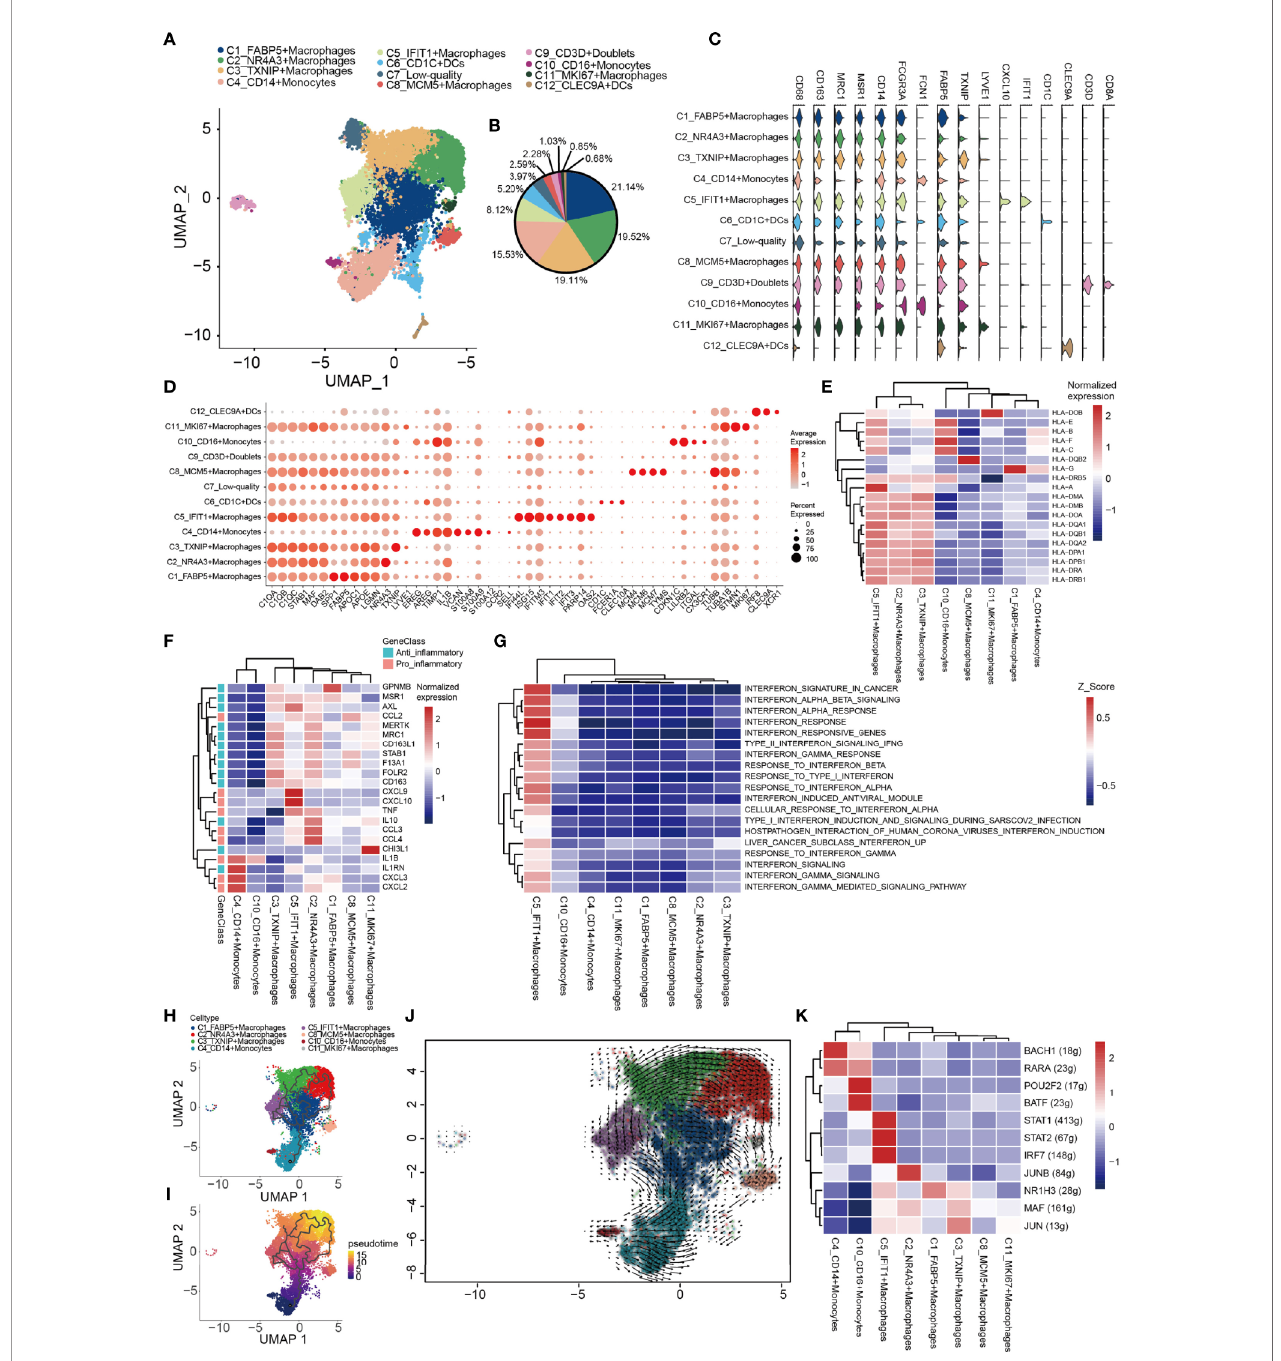
FIGURE 5 | Heterogeneity of myeloid cells populations in human OS. (A) UMAP plot showing the myeloid cells, with different cell types represented by the different colors. (B) Pie chart showing the cell composition of myeloid cells, with different cell types represented by the different colors. (C) Violin plots showing relevant marker genes of the myeloid cell subtypes. (D) Dot-plot of marker genes in each cell subtype; shades of red represent the expression level, and dot sizes represent the relative abundance. (E) Heat map showing the encoding major histocompatibility complex class I and II molecules of the genes of each macrophage subtype. (F) Heat map showing the anti-in fl ammatory and pro-in fl ammatory genes of each macrophage subtypes. (G) GSVA showing the interferon-related functions of each macrophage subtype. (H, I) Differentiation and developmental trajectories of different cell subtypes in macrophages. (J) RNA velocity fi eld projected onto the UMAP plot of the macrophages; arrows indicate the direction of differentiation and the average velocity. (K) Heat map of the AUC scores of expression regulation by transcription factors estimated by SCENIC. OS, osteosarcoma; UMAP, uniform manifold approximation and projection; GSVA, gene set variation analysis; SCENIC, single-cell regulatory network inference and clustering; AUC, area under the